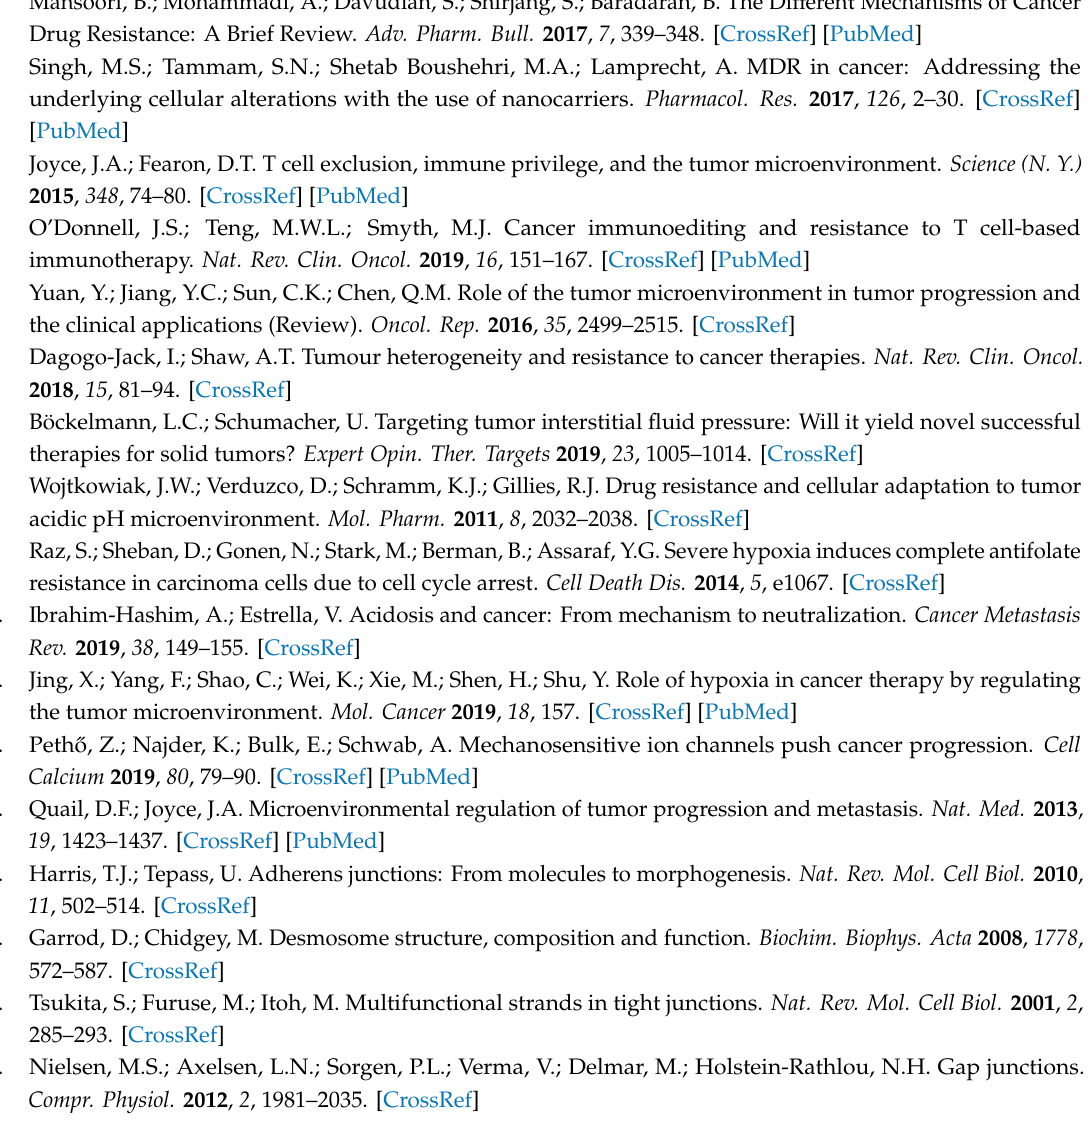
Figure S1: Viability of cells within the formed spheroids SKOV3 and SKOV3ip. Spheroids of both cell lines at days 2, 6, and 9 were disaggregated, the resulting cell suspension was stained with 0.4% trypan blue solution, and the number of living / dead cells was counted with